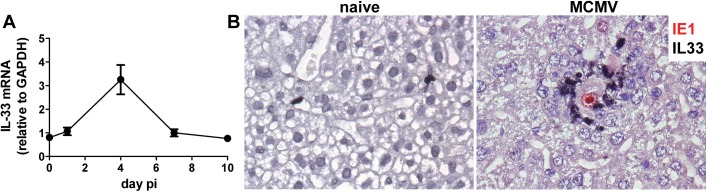
IL-33 expression is increased during MCMV infection.BALB/c mice were injected i.v. with 2x105 PFU of WT MCMV (MW97.01) and liver tissue was harvested on indicated time points. (A) Kinetic analysis of IL-33 mRNA expression, relative to GAPDH mRNA, performed by real-time PCR. (B) Representative IL-33 (black) and MCMV IE1 (red) co-staining of paraffin embedded liver sections on day 5 p.i.